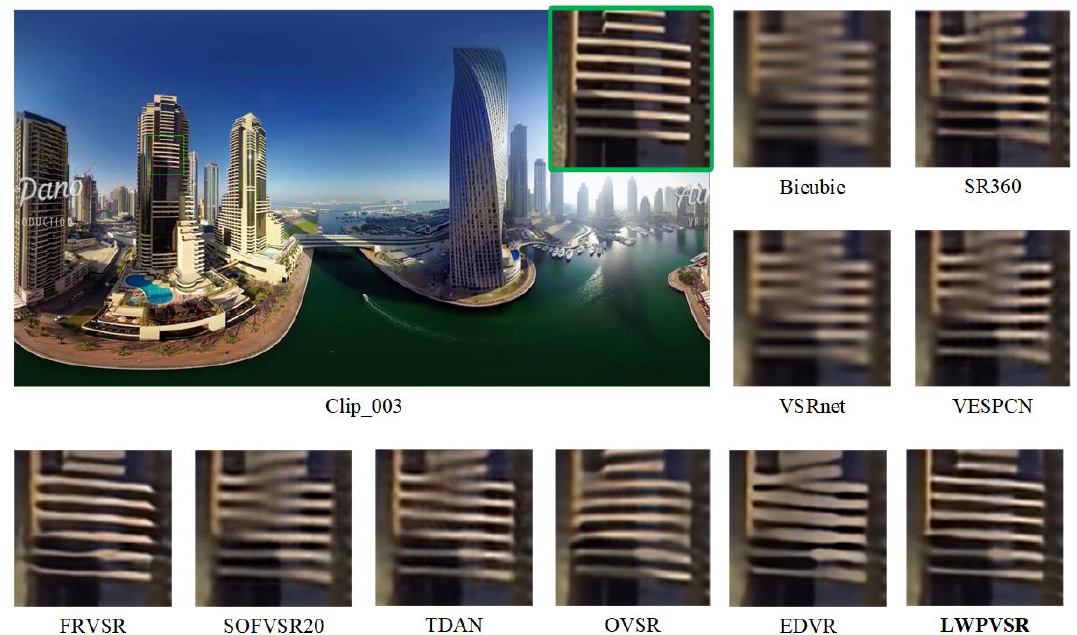
Figure 8. The results of all the algorithms performing 4 × super-resolution on Clip_003 of the MiG test set.